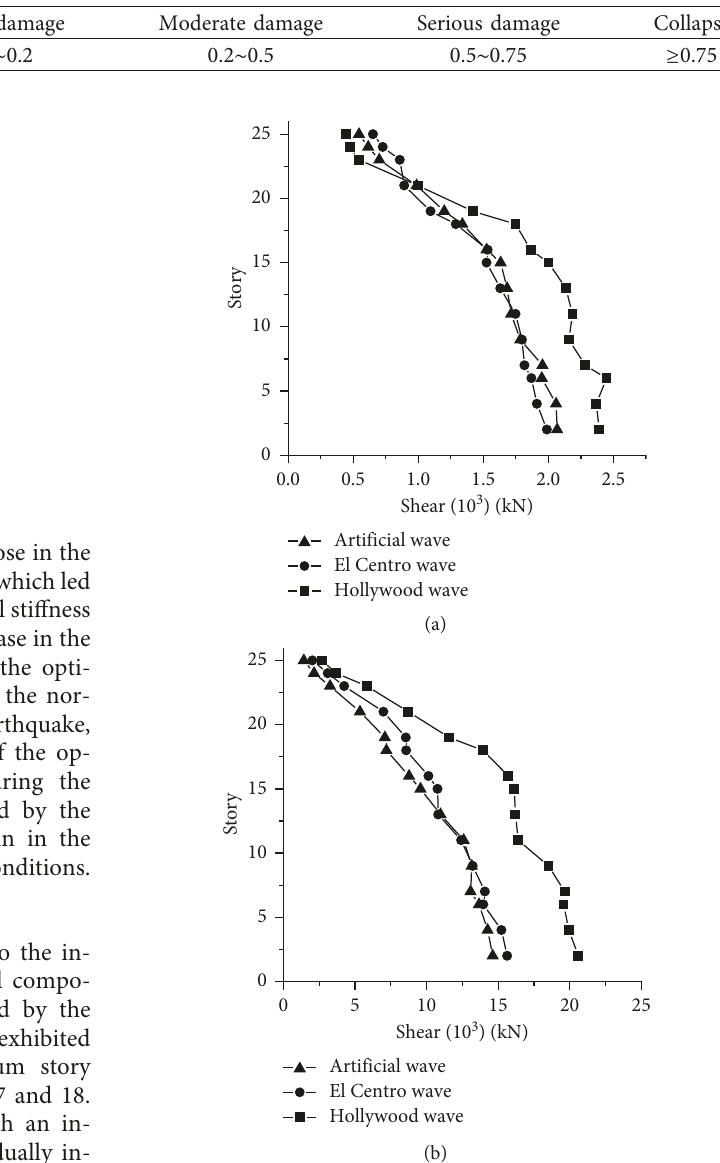
Figure 17: Story maximum shear of optimization model. (a) Frequent intensity 7; (b) rare intensity